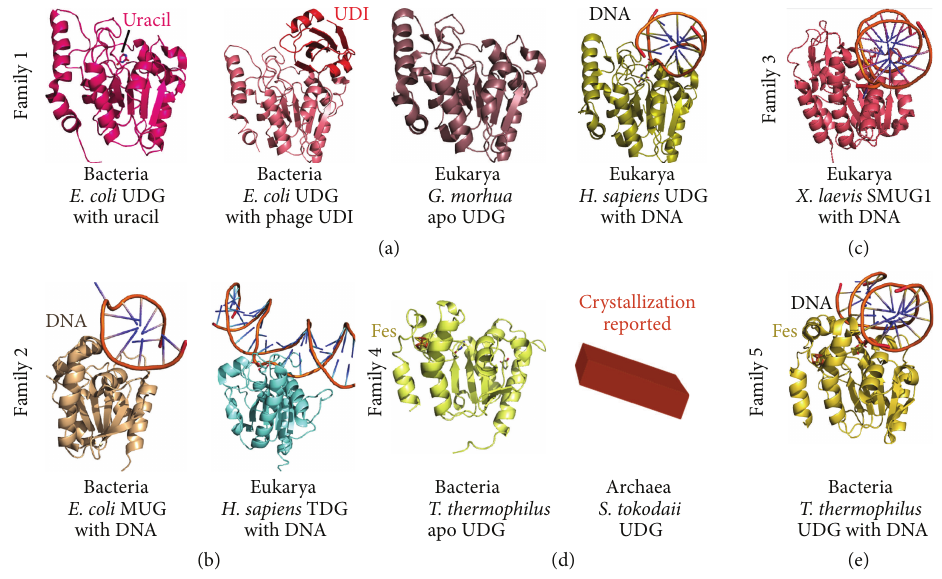
Figure 3: Representative structures of UDGs from families 1–5. (a) Family 1: bacterial UDG monomer with uracil from E. coli (PDB code 1FLZ) and E. coli UDG (PDB code 1UUG) bound to a Bacillus phage inhibitor (UDI). Eukaryotic UDG structures exemplified by apo G. morhua UDG (PDB code 1OKB) and DNA-bound human UDG (PDB code 1EMH). (b) Family 2: E. coli MUG in complex with DNA (PDB code 1MWJ); human TDG (PDB code 2RBA). (c) Family 3: X. laevis SMUG1 in complex with DNA (PDB code 1OE4). (d) Family 4: bacterial UDG (with Fe-S) from T. thermophilus UDG (PDB code 1UI0). Determination of the X-ray structure from S. tokodaii will shed light on archaeal UDG homologs. (e) Family 5: T. thermophilus UDG (with Fe-S) bound to DNA (PDB code 2DEM). Archaea contain homologs from families 2, 4, and